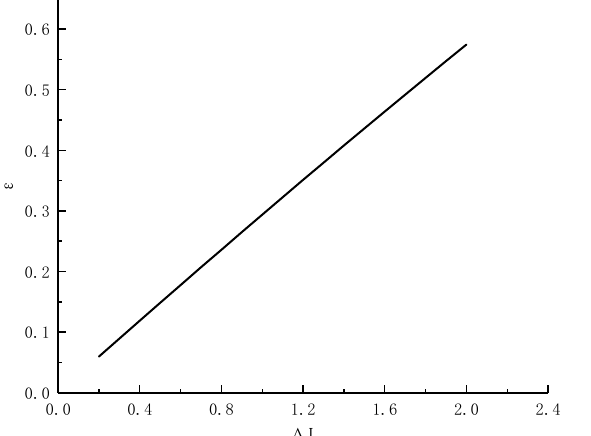
Figure 6. Fitting curve between displacement, ∆ L , and measured strain, ε , produced by grating bending.